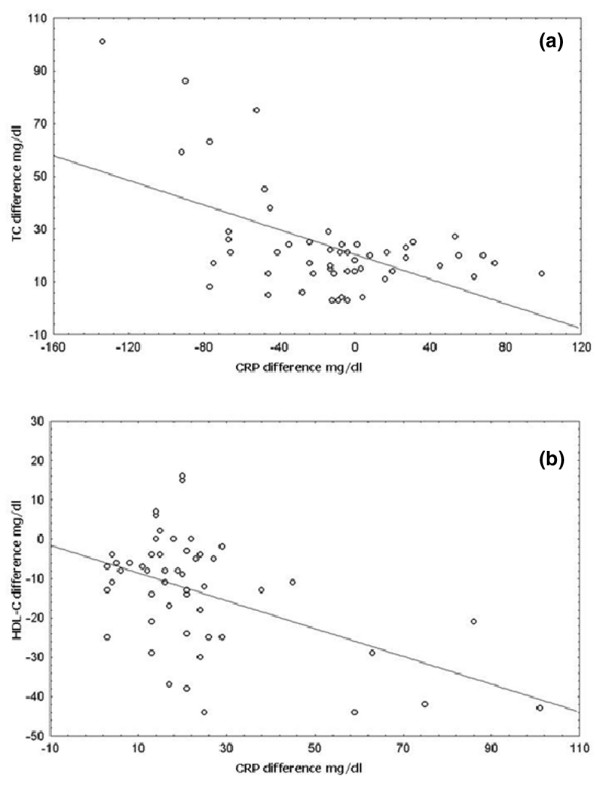
Correlation of total cholesterol (TC) and high-density lipoprotein cholesterol (HDL-C) with C-reactive protein (CRP). Inverse correlation of CRP differences with (a) TC and (b) HDL-C differences (r = -0.54, p < 0.0001 and r = -0.59, p < 0.0001, respectively).